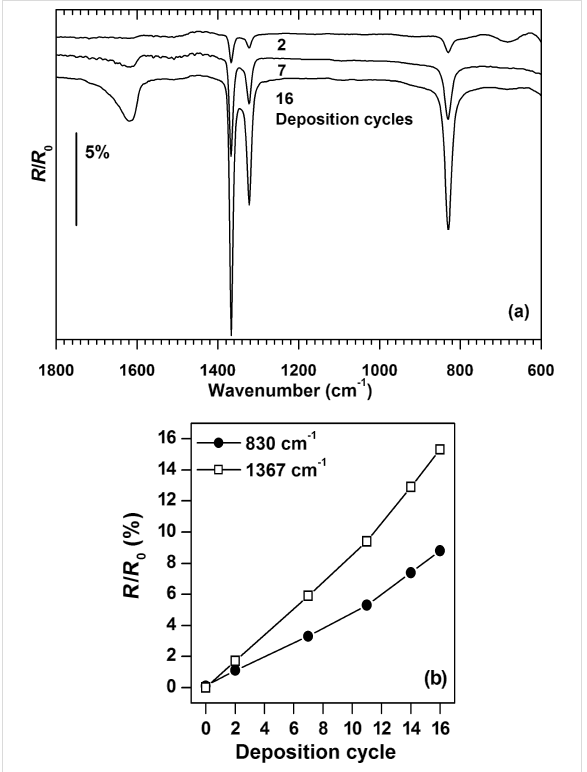
Figure 1: (a) Representative RAIR spectra of surface-grown copper(II) oxalate prepared by the indicated numbers of deposition cycles with acquisition being performed after dipping in oxalic acid solution (b) Band intensities as a function of the deposition cycles. All samples were grown on MUA-coated gold substrates, which were also used for recording background